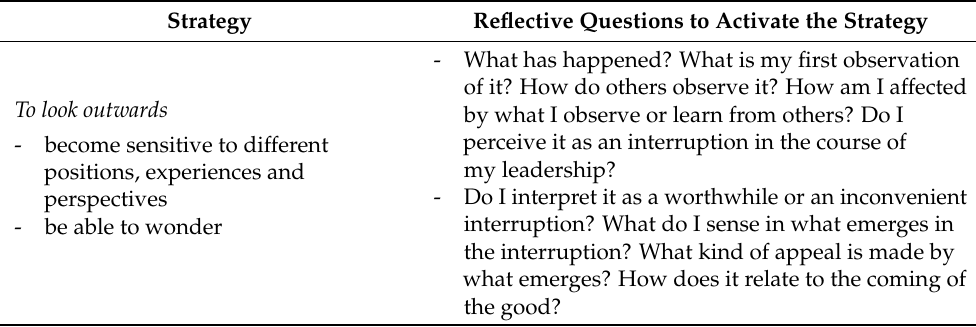
Table 1. Strategies for practical, wise leadership, and reflective